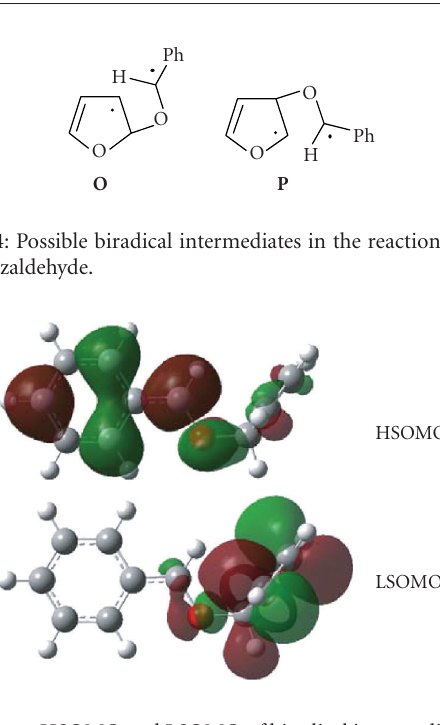
Figure 5: HSOMO and LSOMO of biradical intermediate O .